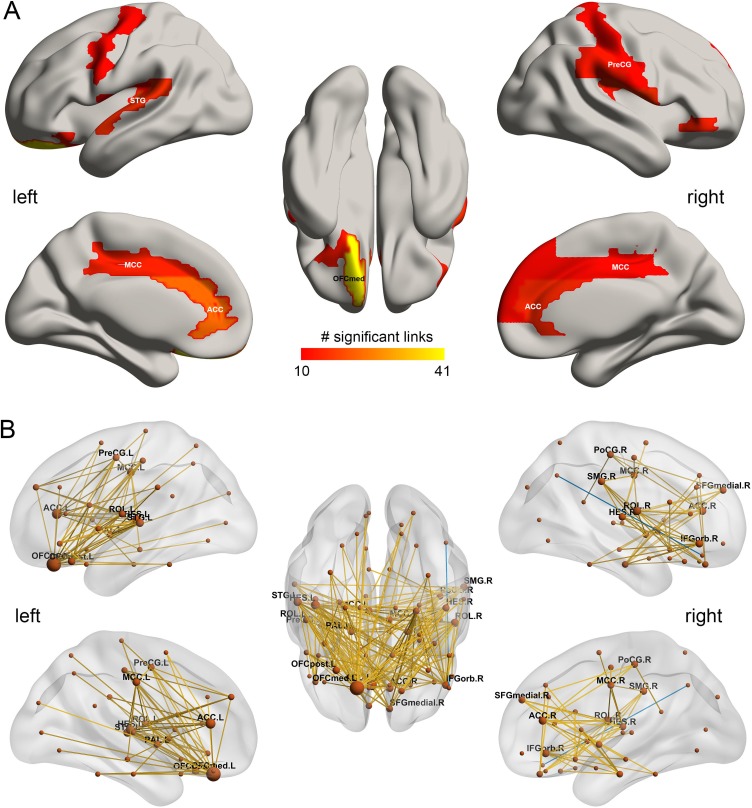
The drinking associated functional connectivities.(A) The AAL2 areas with different functional connectivity (measured by the number of significant links FDR p<0.05) involving that area, using a threshold of 10 links for high drinking compared to the low-drinking group. OFCmed – medial orbitofrontal cortex; ACC – anterior cingulate gyri; MCC – middle cingulate gyri; PreCG – precentral gyrus; STG – superior temporal gyrus; (B) Significant links (FDR p<0.05) between the AAL2 areas with red showing a increase for the drinking group.10.7554/eLife.40765.012Figure 3—source data 1.All significant links (FDR p<0.05) between the AAL2 areas for the drinking group.